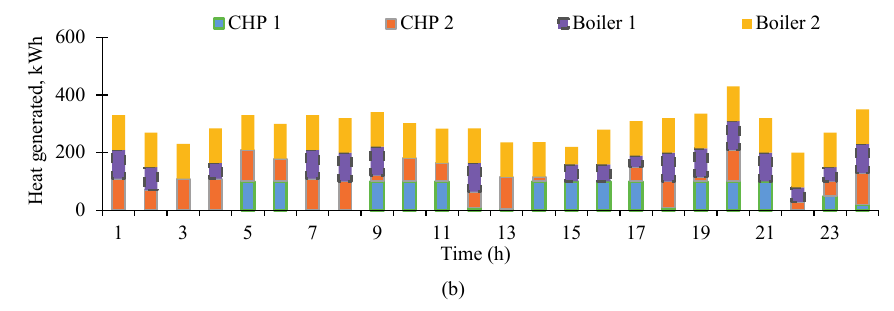
Fig. 8. Heat generated: (a) Case 1, and (b) Case